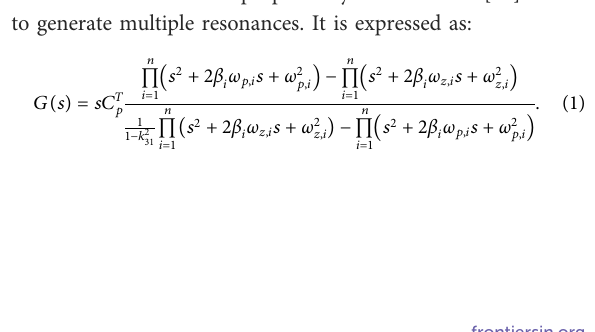
bonded to the base shell is grounded, between the upper and Figure 1B. Details about the digital circuit are provided in [35].